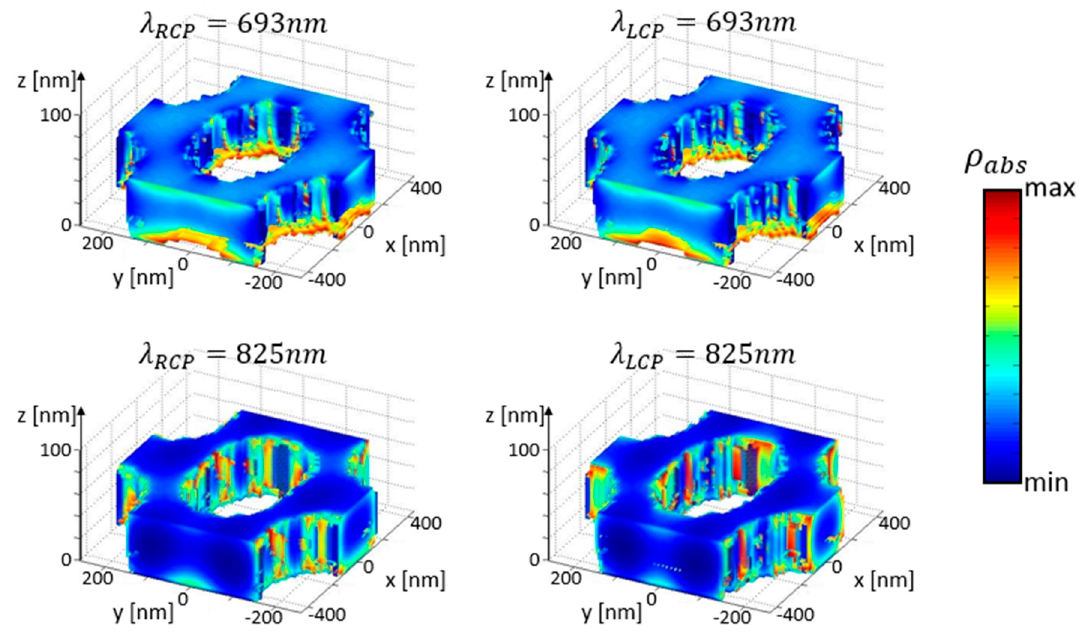
Figure 4. Simulated absorption densities for RCP and LCP excitations at the resonant wavelength (693 nm) and the maximum CD wavelength (825 nm). The color scale is equal for all distributions.